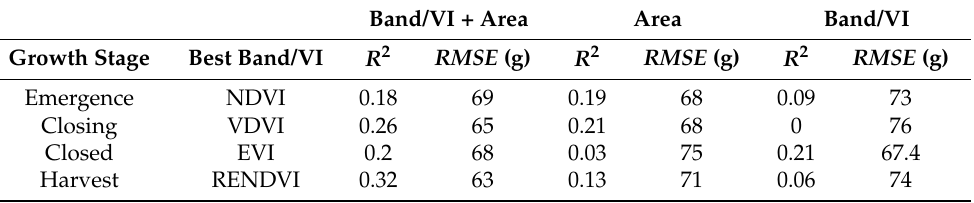
Table 7. Table beet growth stage and band/VI assessment report with leave-one-out cross-validation R 2 and root mean squared error (RMSE) for the best pairing of a radiometric feature with canopy area MLR model and the linear regression scores of the individual features in New York in